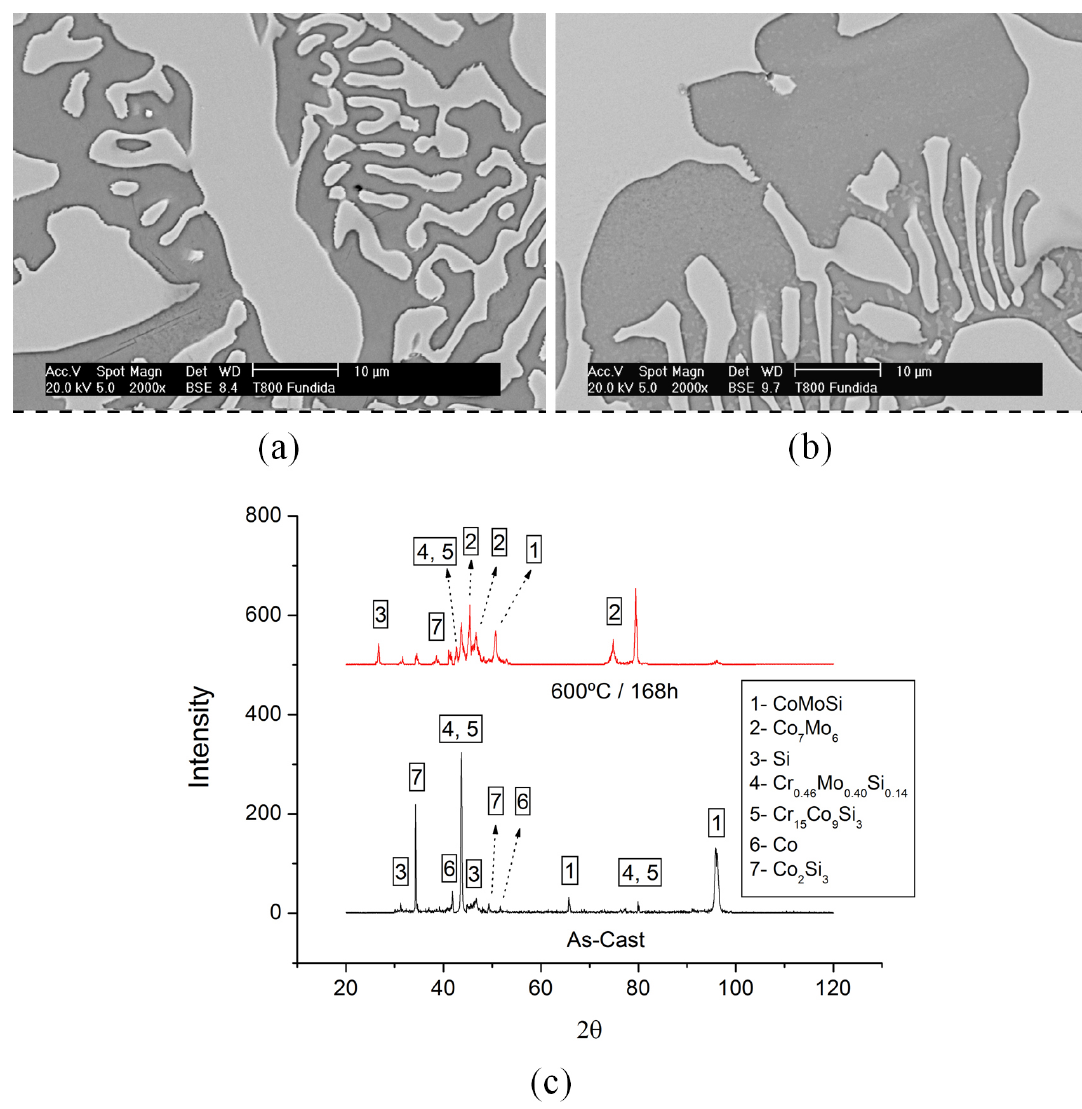
Figure 3. Microstructure of the Cast CoCrMoSi alloy (a), exposed to 600 °C for 168h (b) and new phases formed by temperature exposure